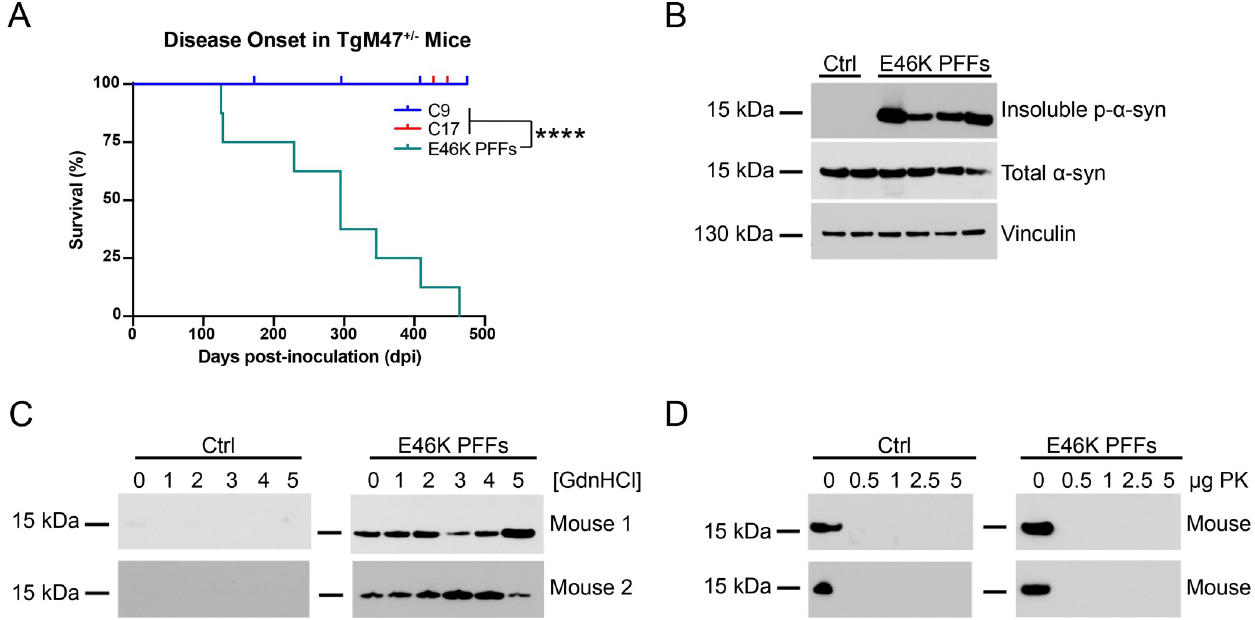
Fig 2. E46K PFFs transmit neurological disease to TgM47 +/- mice. Eight-week-old TgM47 +/- mice were inoculated with 30 μ g of E46K α -synuclein PFFs or 30 μ L of 1% brain homogenate from control patient samples. (A) Kaplan-Meier plot shows E46K PFFs induced neurological disease 286 ± 122 days postinoculation (dpi; ���� P < 0.0001). (B) Two brain homogenates from TgM47 +/- mice inoculated with control patient samples and four homogenates from mice inoculated with E46K PFFs were assayed for the presence of insoluble α -synuclein following detergent extraction. All four homogenates from E46K PFF– inoculated mice contained phosphorylated α -synuclein (EP1536Y primary antibody). All mice tested expressed similar levels of total α -synuclein (MJFR1 primary antibody). Vinculin shown as a loading control. (C) Guanidine hydrochloride (GdnHCl) denaturation was performed using brain homogenates from two control-inoculated (left) and two E46K PFF–inoculated TgM47 +/- mice (right) using 0, 1, 2, 3, 4, and 5 M GdnHCl. After detergent extraction, α -synuclein in the resulting protein pellet was detected via Western blot with the total α -synuclein antibody MJFR1. (D) Proteinase K (PK) digestion was performed using brain homogenates from two control-inoculated (left) and two E46K PFF–inoculated TgM47 +/- mice (right) using 0, 0.5, 1, 2.5, and 5 μ g PK. After detergent extraction, total α -synuclein in the resulting protein pellets was detected via Western blot with the antibody MJFR1.